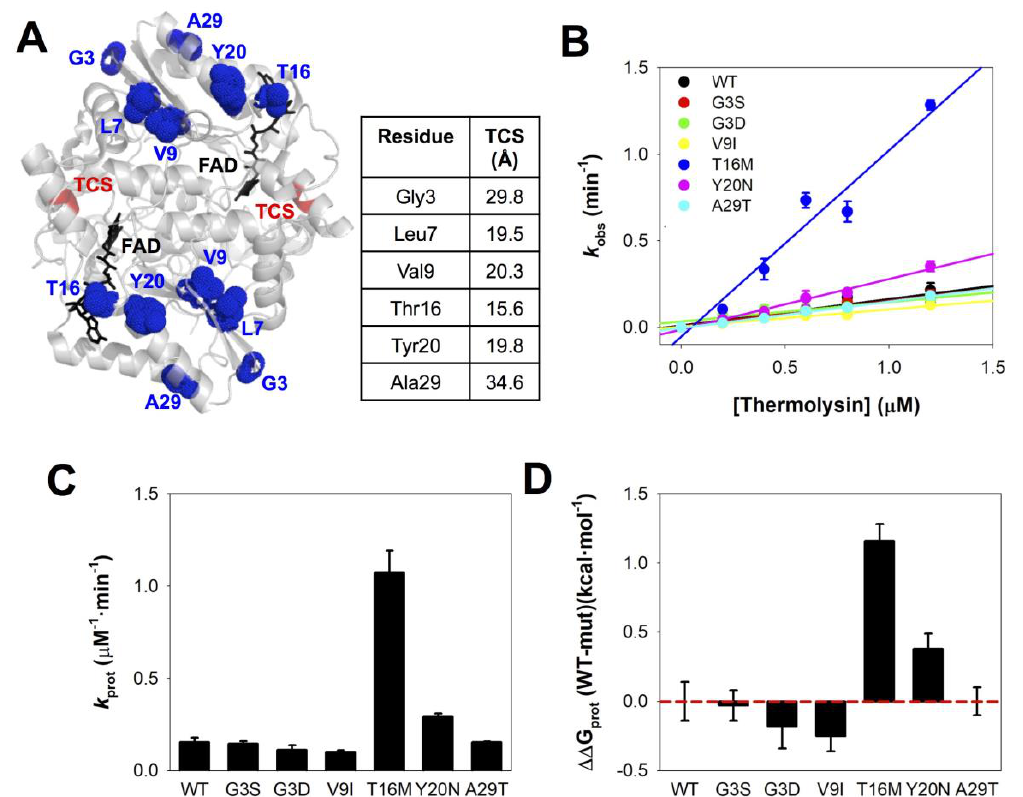
Figure 4. Local stability of the N-terminal domain (NTD) probed by proteolysis with thermolysin. ( A ) Location of mutated residues regarding the thermolysin cleavage site (TCS). The minimal distance between the mutated residue and the TCS backbone (Ser72-Val73) is also indicated (using the structure with PDB code 2F1O). ( B ) Linear dependence of apparent rate constants ( k obs ) on protease concentration. The slopes provide the values of the second-order rate constants k prot . ( C , D ) Values of k prot for the NQO1 variants ( C ) and the effect of mutations on the local stability ( D ) as ΔΔG prot . Note that a positive value of ΔΔG prot indicates a destabilizing effect.